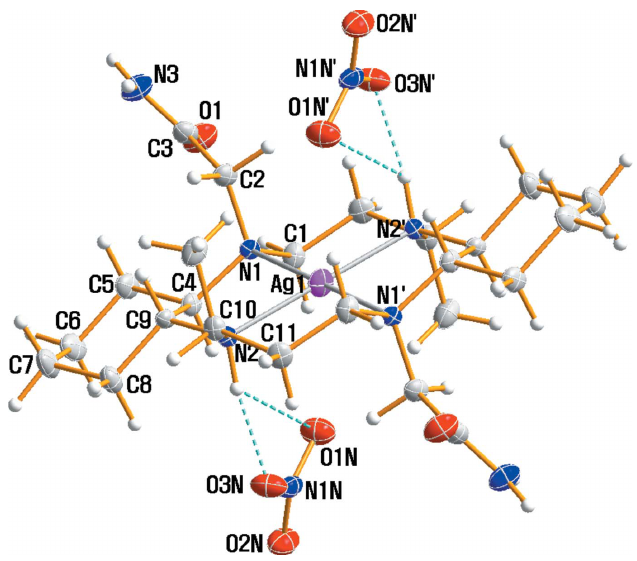
Figure 1 A perspective view (50% probability) of complex (I). The primed atoms are related by the symmetry operation ( (cid:4) x + 1, (cid:4) y + 1, (cid:4) z + 1). Hydrogen bonds are drawn as dashed